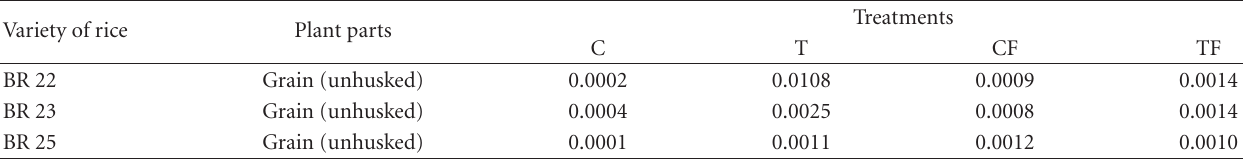
Table 11: Accumulation of As (mg/pot) by the aman rice